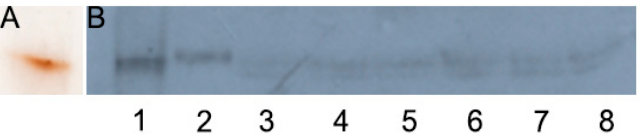
Figure 6. Ceruloplasmin gene activity in KO cells derived from H1299. ( A ) Human serum, 0.025 µ L per line, gel was stained with orto -dianisidine, ( B ) WB with antibodies to human ceruloplasmin: 1, human serum, 0.01 µ L per line; 2, H1299; 3, CTR1 KO45; 4, CTR1 KO46; 5, DMT1 KO31; 6, DMT1 KO20; 7, DKO1; 8, DKO2; 25 µ L medium per line. The proteins were separated in 8% PAG without SDS by electrophoresis.